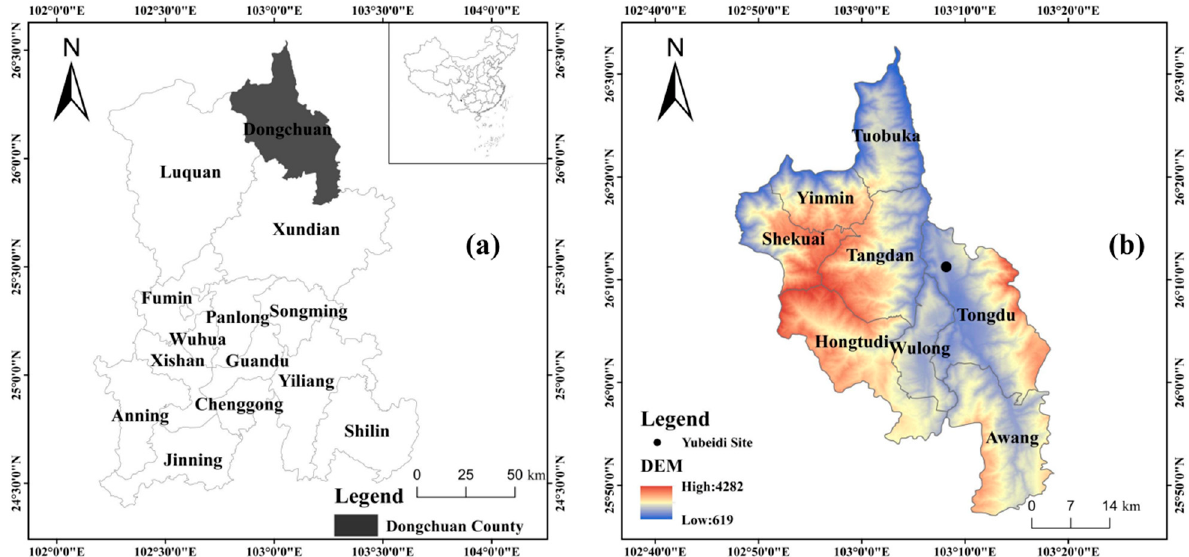
Figure 1. ( a ) Location and ( b ) topographic map of Dongchuan County. The Yubeidi site is marked with a black spot in ( b ).